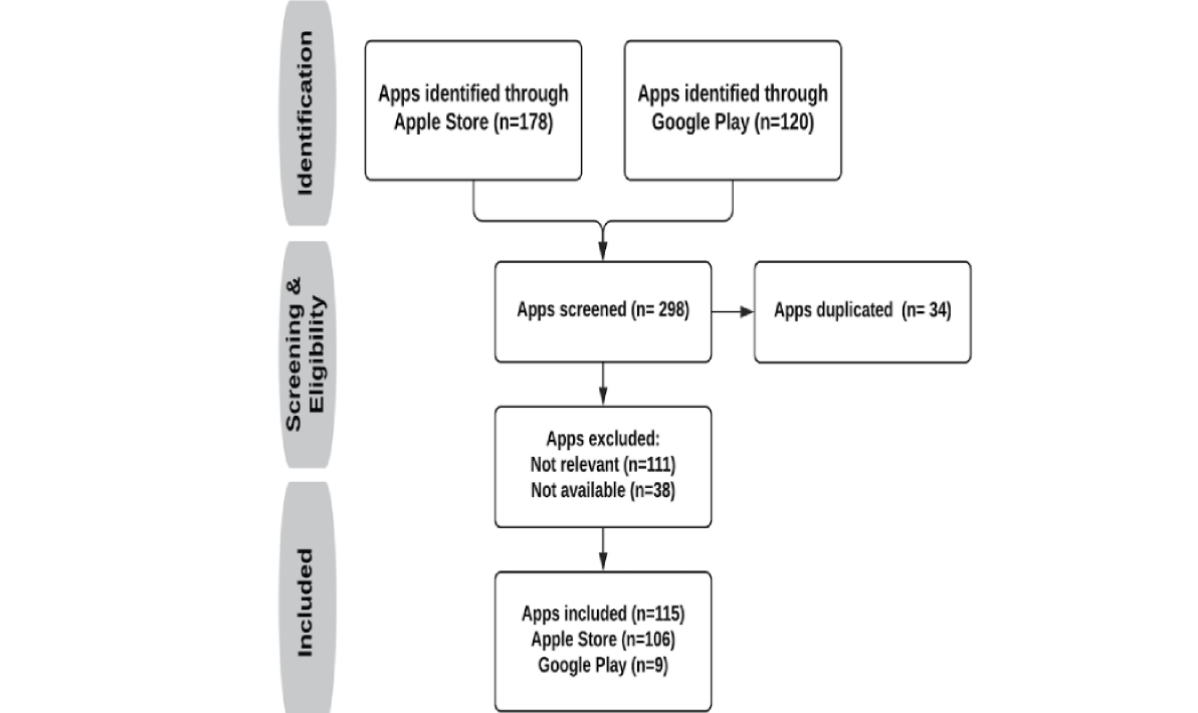
Figure 2. Flowchart of our search strategy and app selection